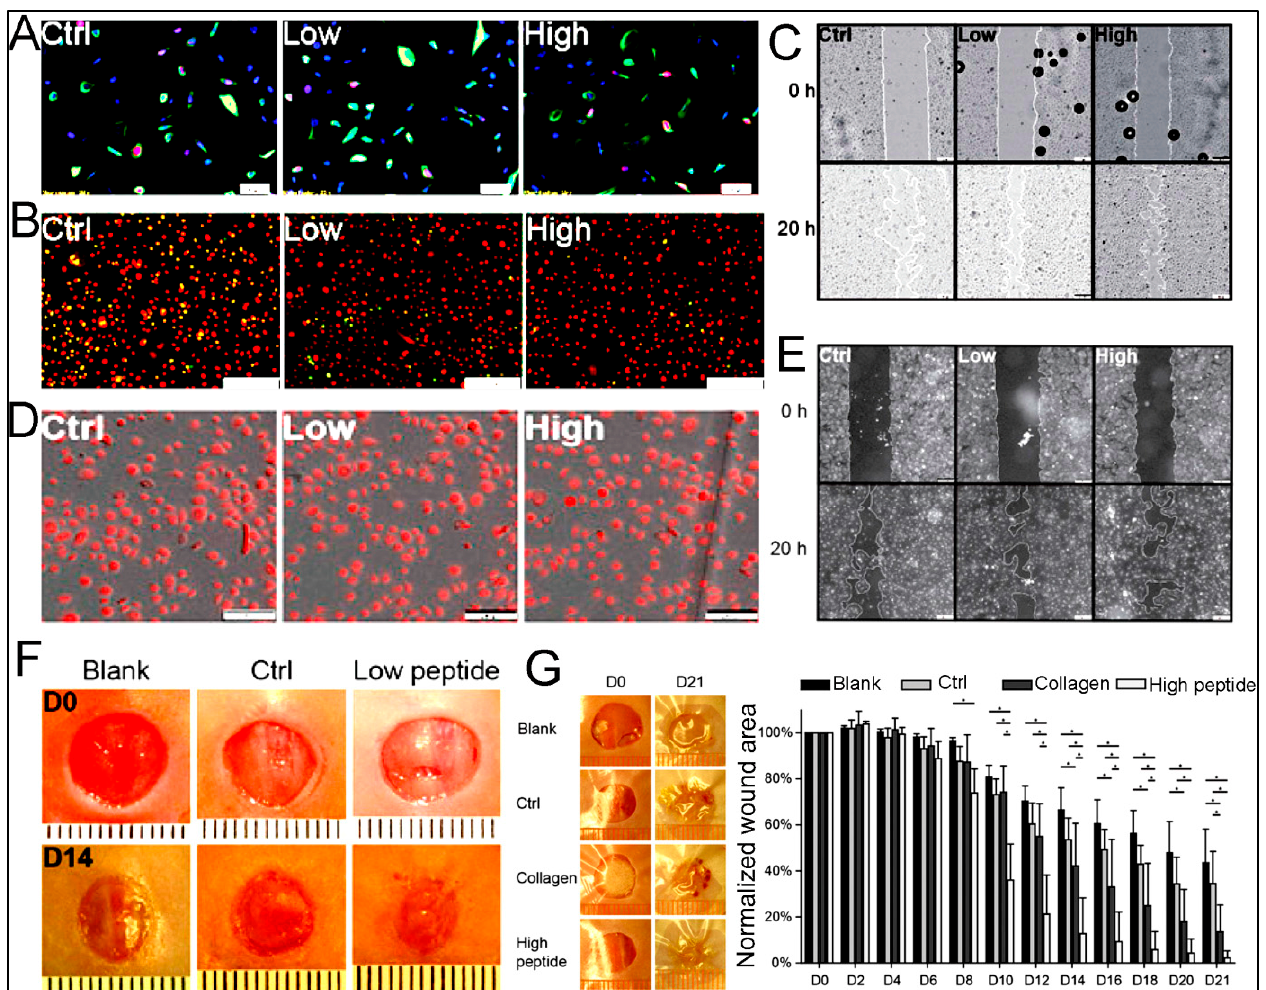
Figure 15. Regeneration and re-epithelialization evaluation of non-healing diabetic wounds with peptide hydrogels treatment. ( A ) Kct-positive human epidermal keratinocytes (HEK) cultured in low (100 μ M) and high (650 μ M) concentrations of QHREDGS peptide exhibited no significant amount of BrdU and similar proliferation rates in all samples. (Scale bar: 50 μ m; Kct: green; BrdU: red; and DAPI: blue). ( B ) The EarlyTox Cell integrity assay demonstrated HEK survival after hydrogen peroxide treatment due to peptide protection (Scale bar: 200 μ m). ( C ) HEK-wounding experiments on designed films in different concentrations of the conjugated peptide by which HEK migration was accelerated in a concentration-dependent manner (scale bar: 200 μ m). ( D ) DHEK attachment was demonstrated on the chitosan-collagen films in different concentrations of QHREDGS peptide (scale bar: 200 μ m). The presence of the peptide caused the promotion of DHEK attachment on chitosan films rather than on chitosan-collagen films. ( E ) DHEK wounding experiment on designed films immobilized with peptide (scale bar: 200 μ m). DHEK migration was increased with peptide in comparison with control. ( F ) Gross images of the initial wounds on days 0 and 14 treated with no hydrogel, peptide-free hydrogel, and low-dose peptide-immobilized hydrogel. ( G ) Gross images of initial wounds on days 0 and 21 treated by no hydrogel, peptide-free hydrogel, ColActive collagen dressing, and High dose peptide immobilized hydrogel. Wound size measurement showed an accelerated wound closure in treatment with peptide. Reprinted with permission from Ref. [304] , Copyright 2016, National Academy of Sciences.